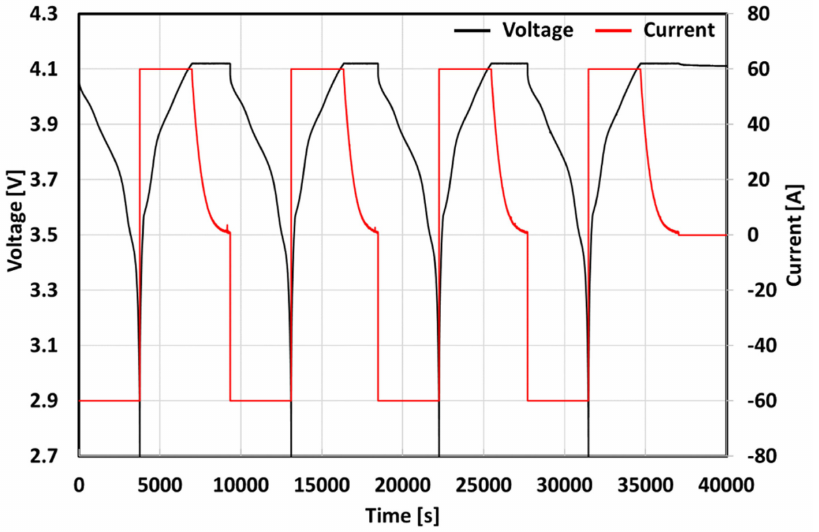
Figure 5. Capacity test performed with a prismatic lithium-ion battery cell at 1C (C-rate) charge (CC) and 1C discharge